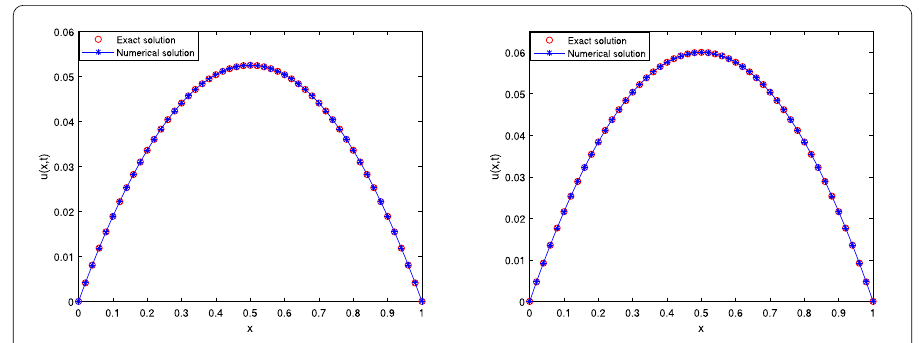
Figure 5 Approximate and analytical solutions of Example 6.2 for n = 3 with final times T = 0.3 (left), T = 0.6 (right), and φ ( h ) = –(exp(–1.2 h ) – 1)/1.2